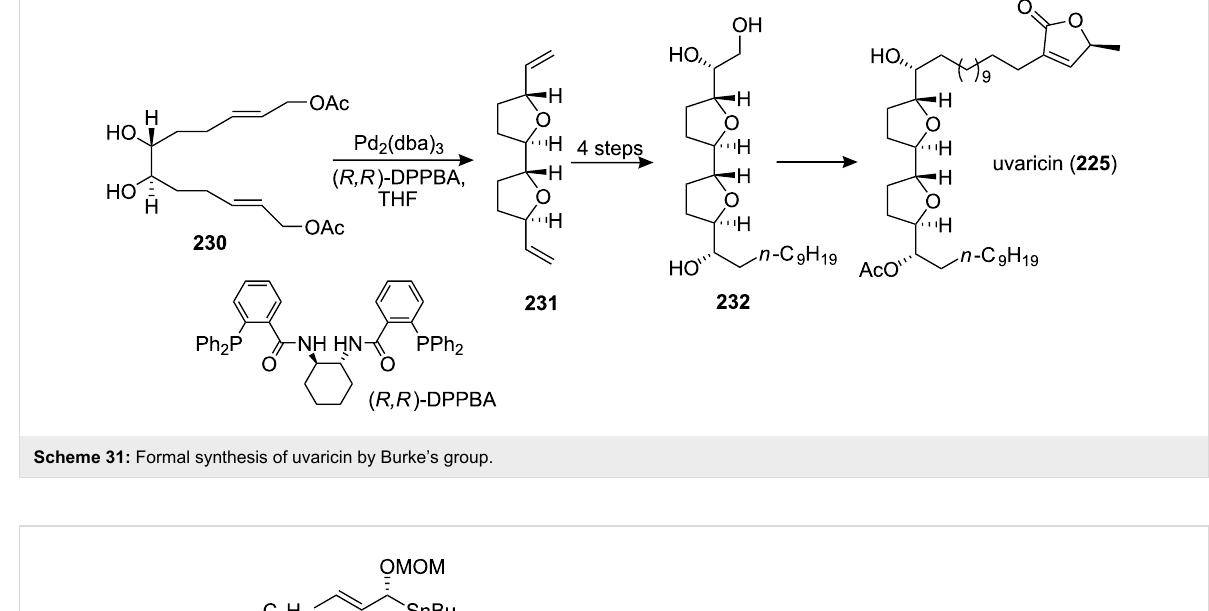
Scheme 31: Formal synthesis of uvaricin by Burke’s group.